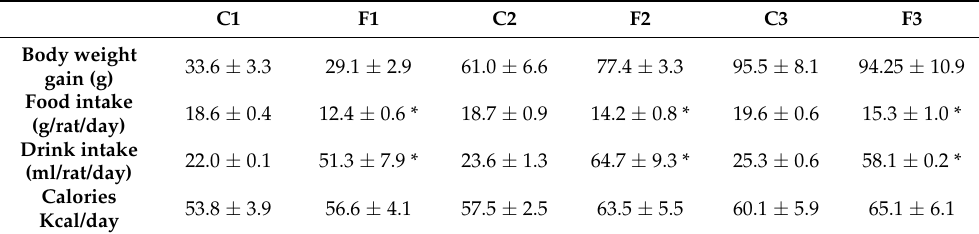
Table 2. Body weight, food and drink intake and calories consumed at each time point.